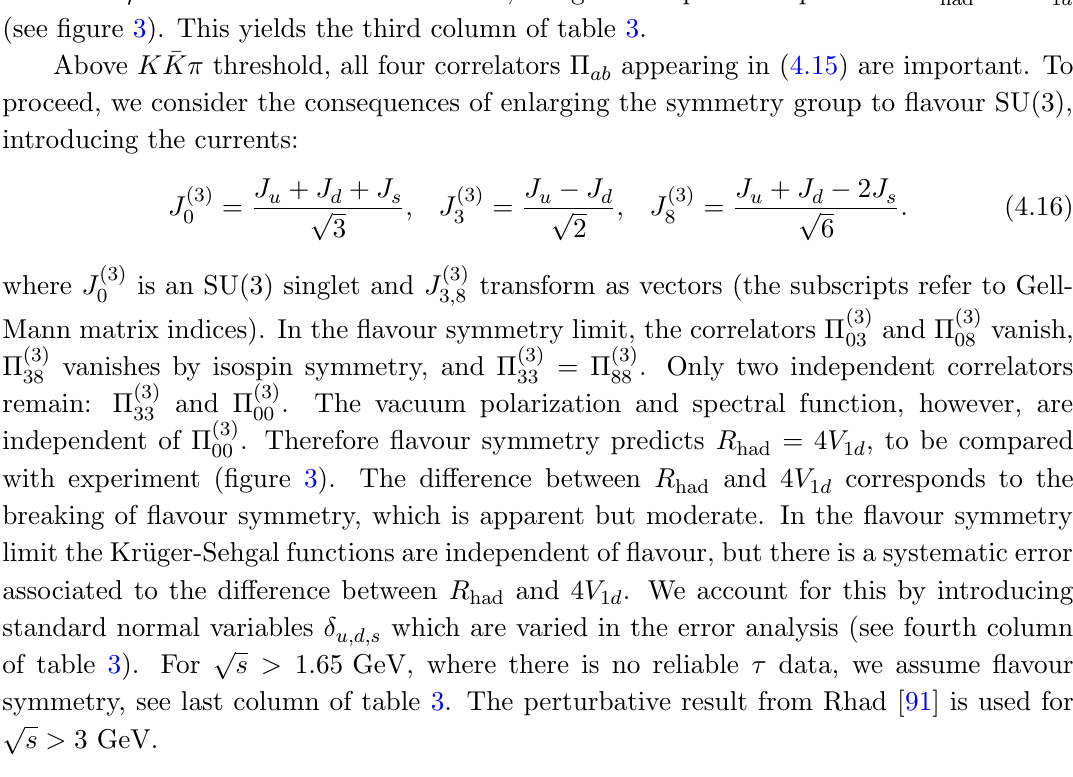
(see (cid:12)gure 3). This yields the third column of table